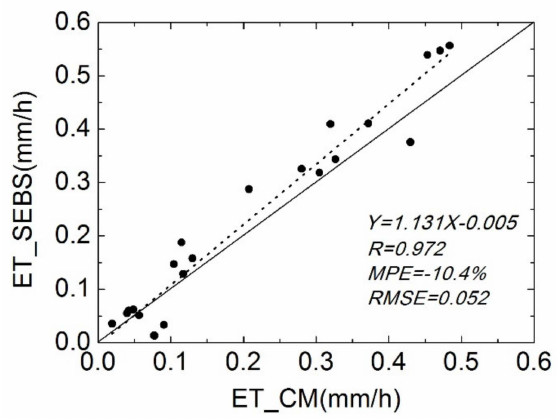
Figure 5. Comparison between derived AET from SEBS and CM at four stations of NPAM, BJ, D105, and